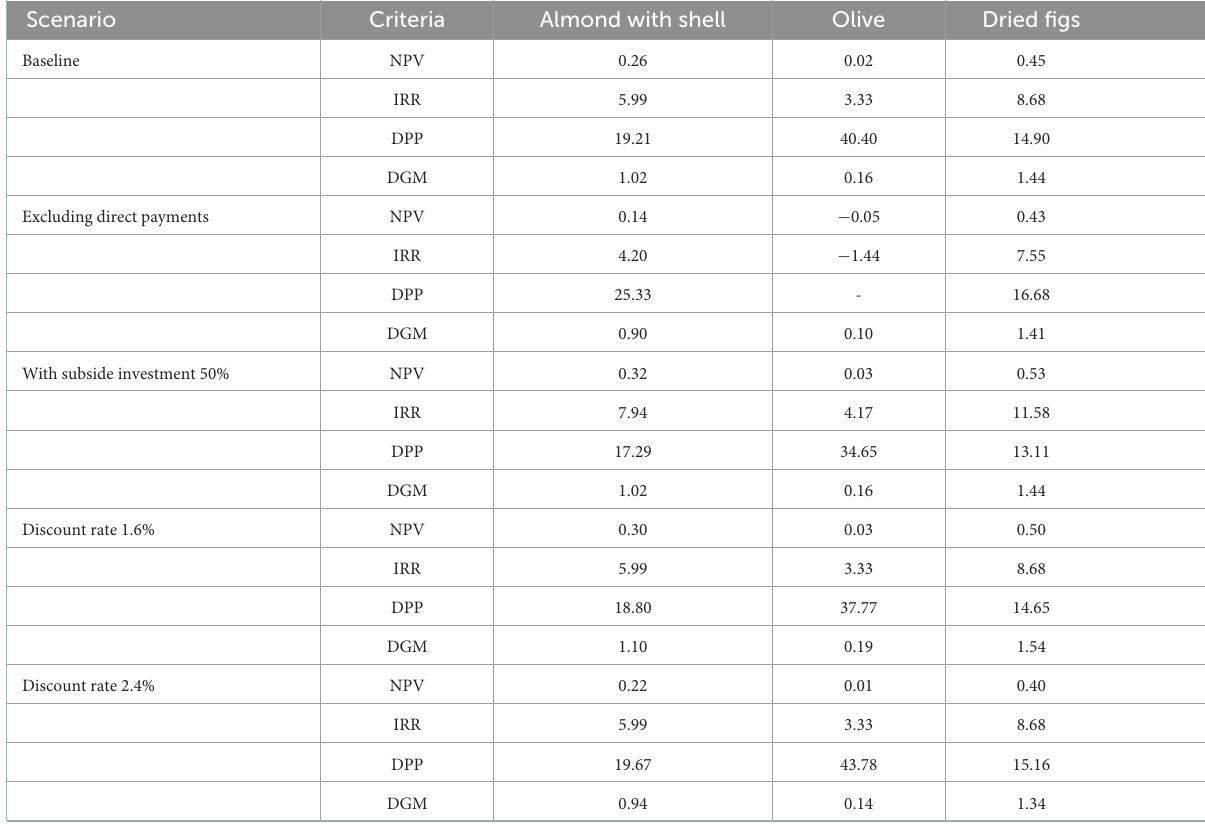
TABLE 7 Sensitivity analysis results: Part